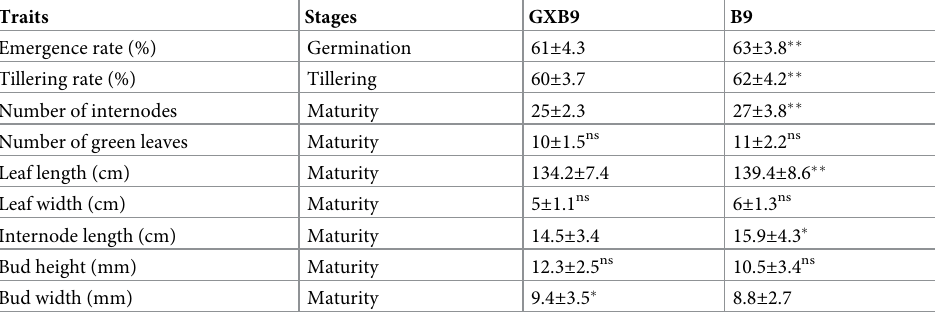
Table 3. Comparison of agro-morphological traits between GXB9 and B9. Traits Stages GXB9 B9 Emergence rate (%) Germination Tillering rate (%) Number of internodes Maturity Number of green leaves Leaf length (cm) Leaf width (cm) Internode length (cm) Maturity Bud height (mm) Bud width (mm) 8.8 ± 2.7 ns = non-significant, � = significant at P � 0.05 �� = highly significant at P � 0.01, ± values represent standard error among